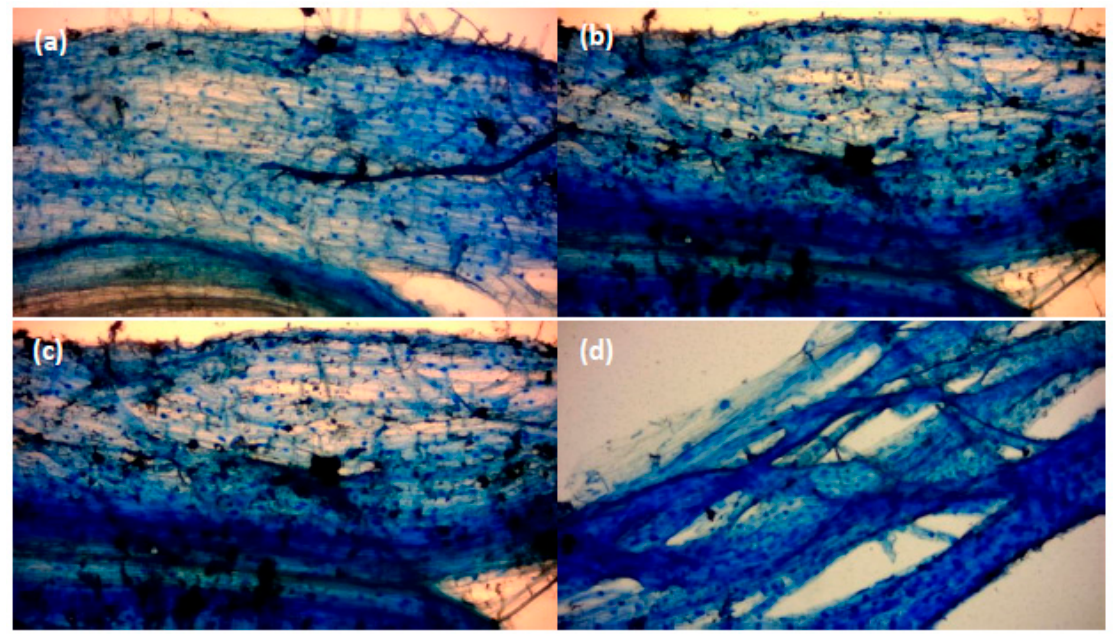
Figure 2. Winter wheat root sections at two weeks post germination stained with Sheaffer ® blue: ( a ) control, ( b ) B. subtilis , ( c ) B. pumilis , and ( d ) B. amyloliquefaciens . Image taken with an Apex ® microscope (Chippenham, Wiltshire, UK) at a total magnification of × 100 and a Bresser ® HD (Rhede, Germany) microscope camera.